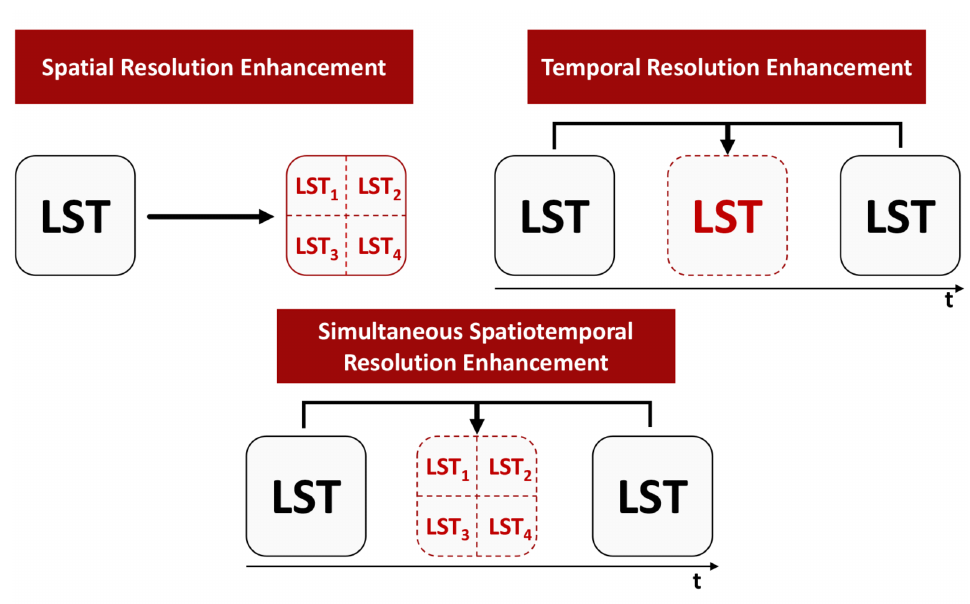
Figure 1. Three groups of LST resolution enhancement